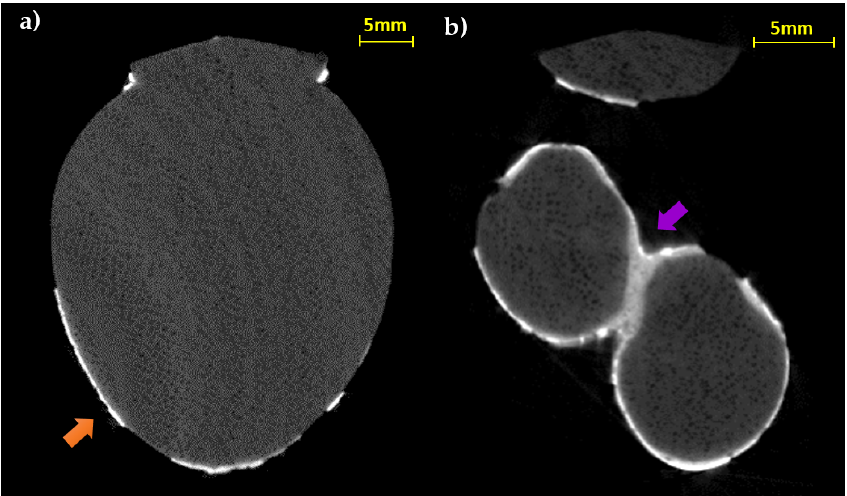
Figure 7. CT horizontal slices of the body ( a ) and the legs ( b ) (orange arrow: thin preparation material for the gold leaf adhesion; purple arrow: thick preparation material between the